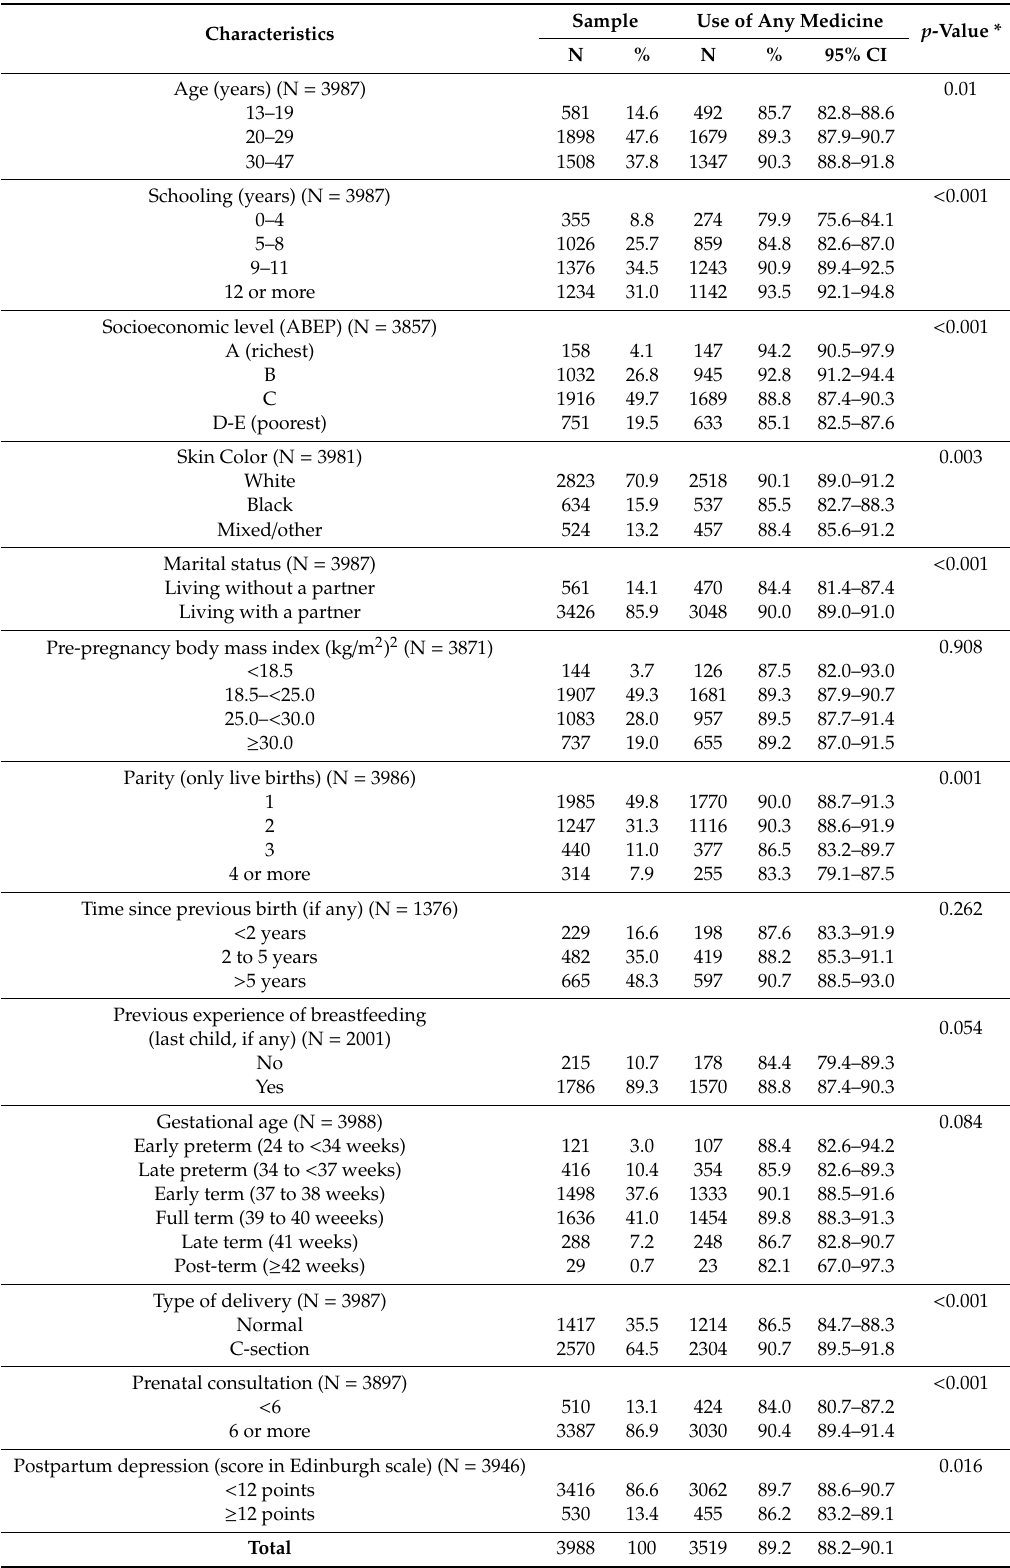
Table 1. Description of the study sample (excluding women who did not breastfeed their children), according to background variables and use of medicines in the first 3 months postpartum. Pelotas (Brazil) Birth Cohort Study, 2015 (N =